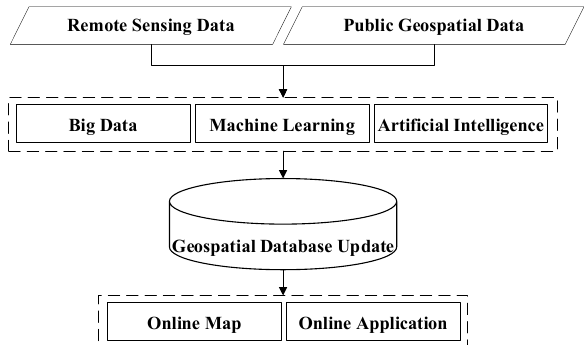
Figure 9 . New development direction of geospatial